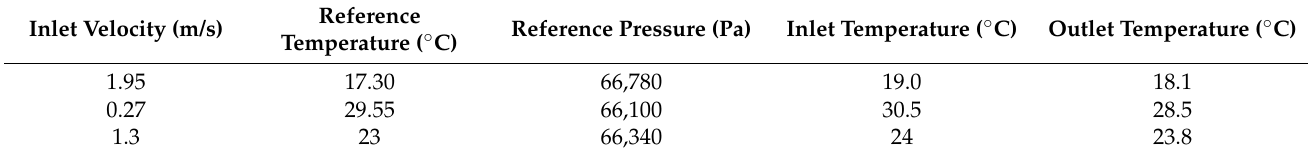
Table 4. Main calculation